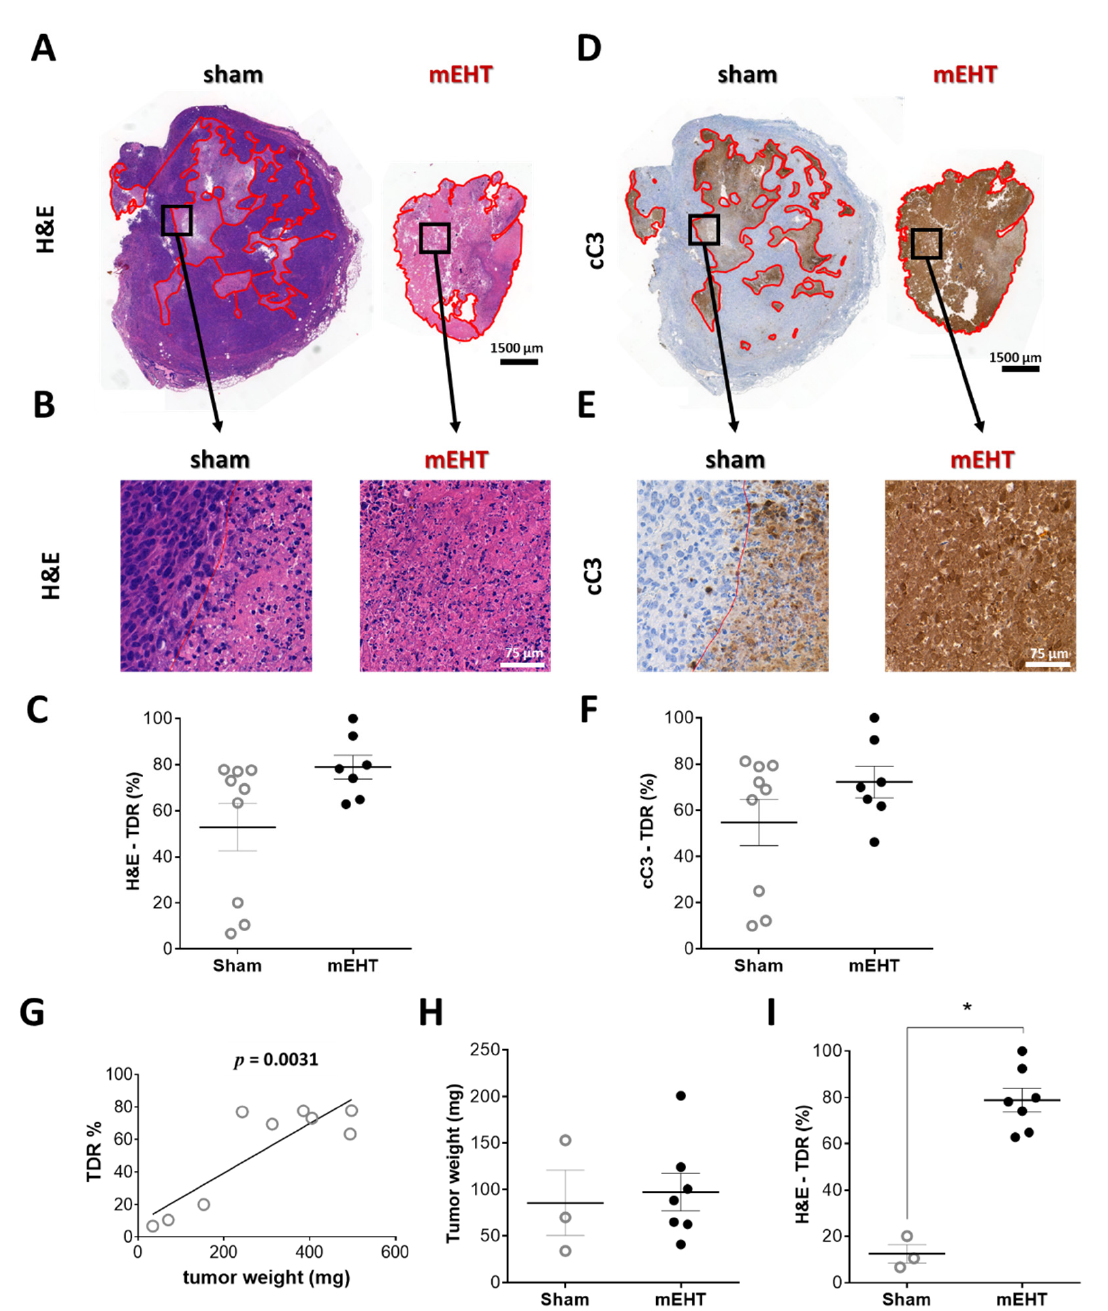
Figure 2. Effect of mEHT treatment on tumor destruction ratio (TDR) in hematoxylin-eosin-(H&E)-stained, and cleaved caspase-3 (cC3) immunohistochemistry-stained sections 24 h after the 5th mEHT treatment. Representative H&E-stained tumors from sham and mEHT-treated groups with 0.9× ( A ) and 40× ( B ) magnification. Destructed area is annotated (red). TDR (%) evaluated on H&E ( A – C ) and cC3 ( D – F ) sections. Representative cC3 ( D , E ) stained tumors with low (0.9×, D ) and high (40×, E ) magnification. Correlation between tumor weight and TDR (%) in sham animals ( G ). Three smallest sham tumors with weights similar to those of mEHT tumors ( H ). Comparison of TDR (%) of sham and mEHT tumors of similar weight ( I ). Mean ± SEM, Mann-Whitney test, n = 7–9/group, *: p < 0.05. Cell line: 4T07, 5× treated.